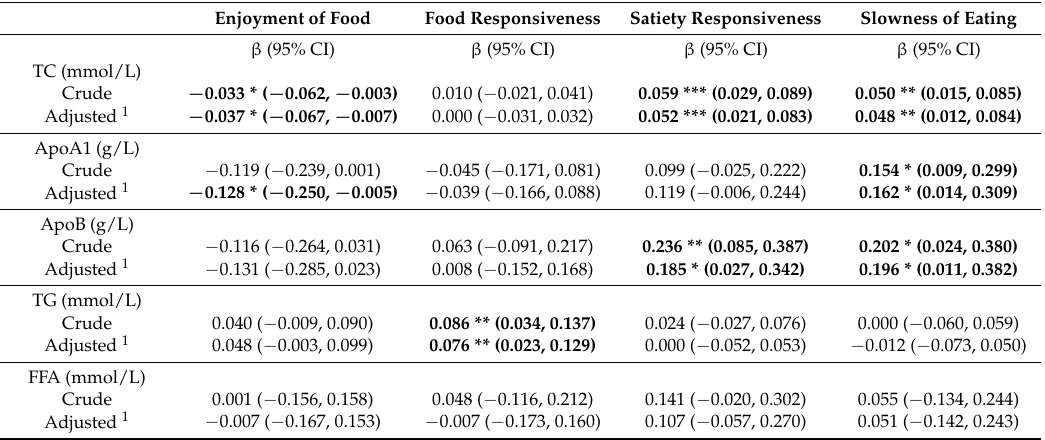
Table 4. Association between prenatal maternal lipid profile and offspring’s eating behaviour at age 5. Enjoyment of Food Food Responsiveness Satiety Responsiveness